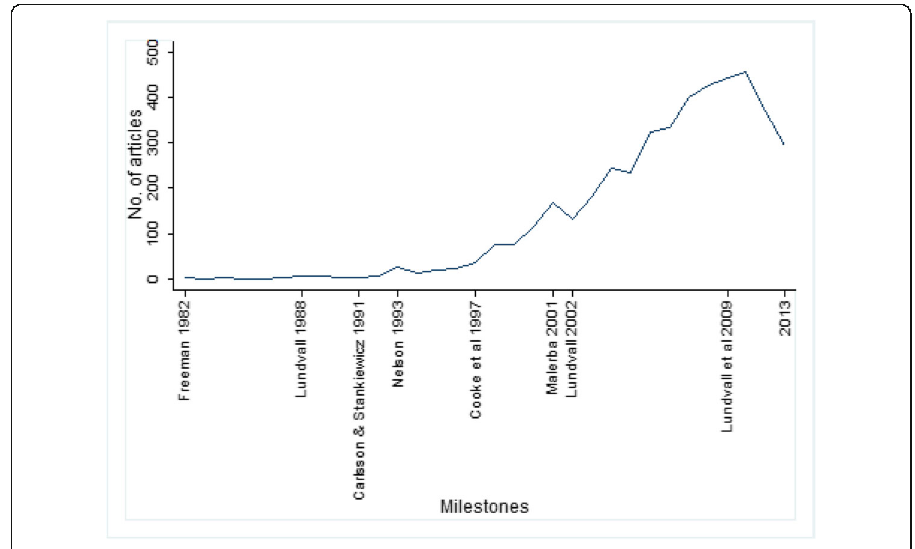
Fig. 1 Trend of Google Scholar articles on innovation system published between 1982 and 2013